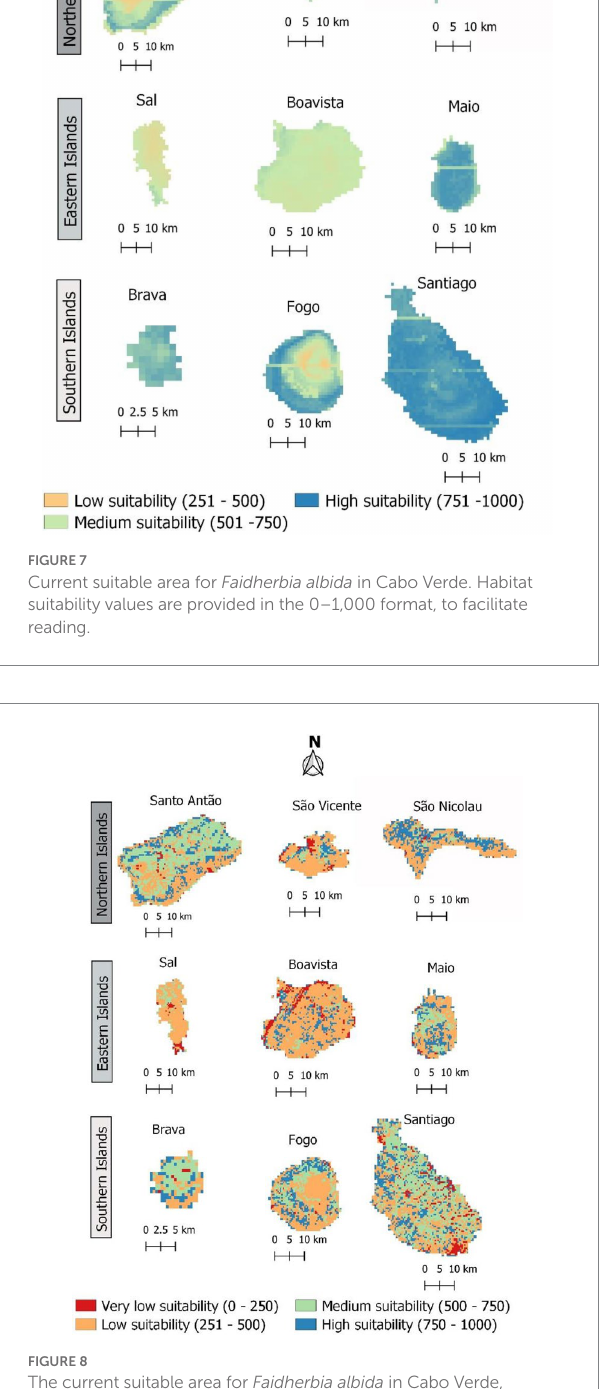
FIGURE 8 The current suitable area for Faidherbia albida in Cabo Verde, according to the results of climatic modelling and the constraints derived from different LULC categories. Suitable areas are those corresponding to probabilities of occurrence above 50%. Habitat suitability values are shown in the format 0–1,000 to facilitate reading. The colors indicate predicted suitable habitats ranging from red (low) to blue (high).